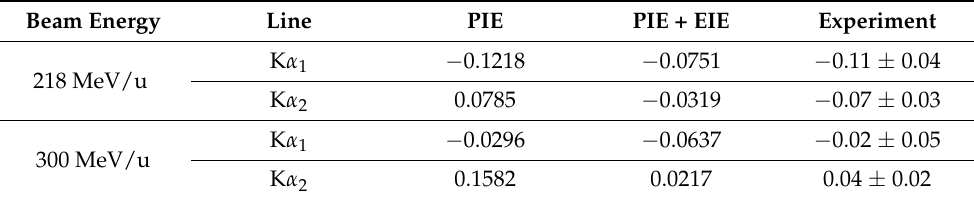
Table 4. Experimental values in comparison with theoretical predictions for the effective anisotropy parameters for the K α 1 and K α 2 lines of helium-like uranium ions produced by K → L excitation in collisions with hydrogen molecules. For details see